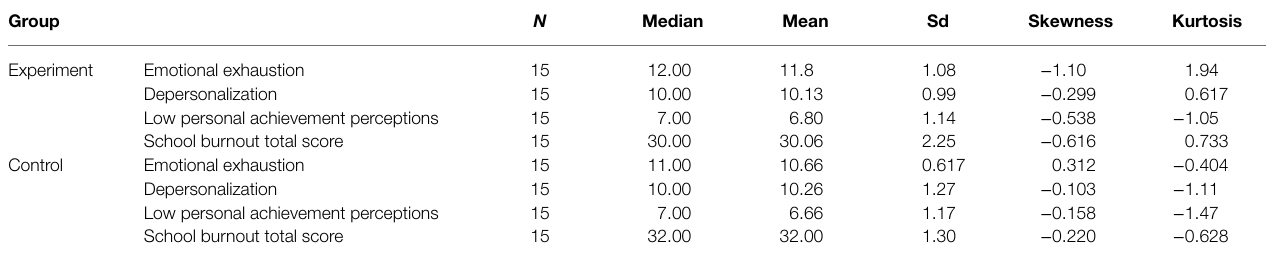
TABLE 1 | Pre-test descriptive statistics and skewness-kurtosis values of experimental and control groups on emotional exhaustion, depersonalization, low achievement perception, total burnout score. Group N Median Mean Sd Skewness Kurtosis